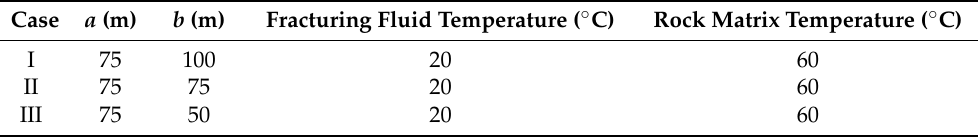
Table 1. Numerical cases of different well spacings.